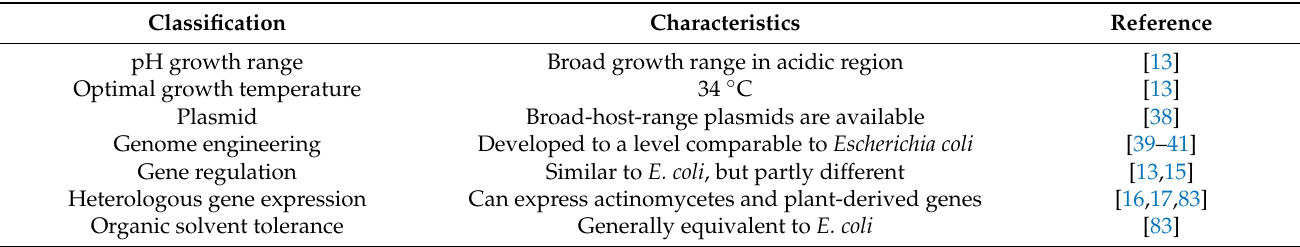
Table 2. Characteristics of Pantoea ananatis